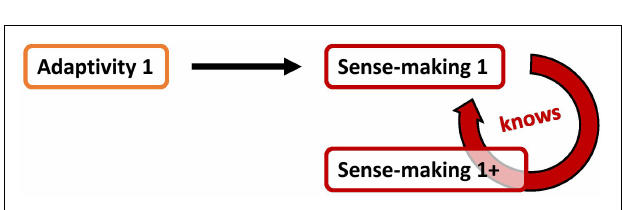
FIGURE 4 | The “sense-making-of-sense-making” approach; the current sense-making act is recognized via an additional act of sense-making.